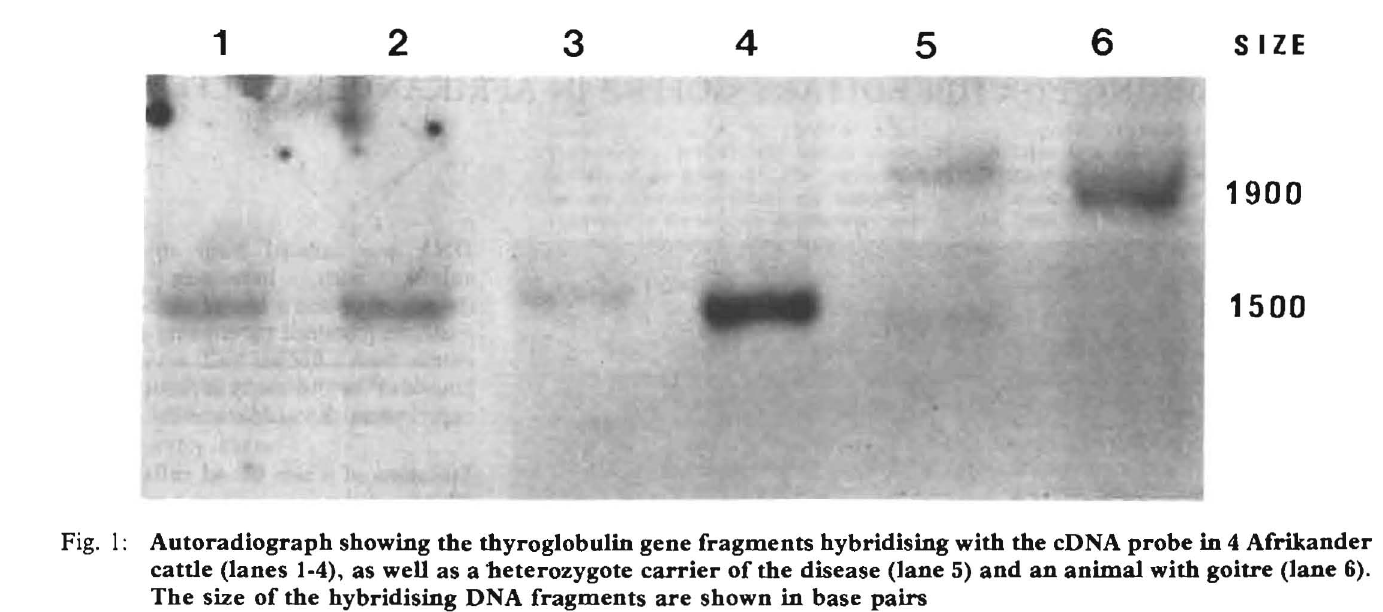
Fig. I: Autoradiograph showing the thyroglobulin gene fragments hybridising with the cDNA probe in 4 Afrikander cattle (lanes 1-4), as well as a heterozygote carrier of the disease (Jane 5) and an animal with goitre (Jane 6). The size of the hybridising DNA fragments are shown in base pairs 32P:labelled probe (500 000 cmp/m/') me was added to 12 of solution and fil ters were hybridised for about 16 h at 42°C with gentle shaking. The filters were then washed 5 times in 3 x SSPE, 0.1 % SDS at room temperature with gentle agitation, then at 42°C in 1 x SSPE, 0,1% SDS and autoradiographed for 2 to 5 d at